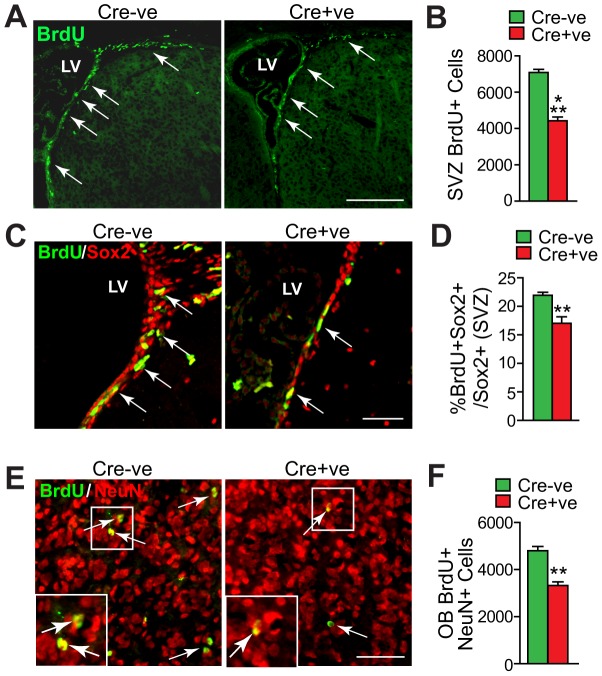
Genetic ablation of Snail perturbs the proliferation of adult forebrain neural precursor cells and the number of adult-born olfactory neurons.(A-D) Adult Snailfl/fl mice that were positive (Cre+ve) or negative (Cre-ve) for the nestin-cre transgene were injected with BrdU and coronal sections through the SVZ were analyzed one day later. (A) Fluorescence micrographs of sections through the SVZ that were immunostained for BrdU (green). Arrows denote BrdU-positive cells in the SVZ and rostral migratory stream. LV indicates the lateral ventricle. Scale bar 100 µm. (B) Quantification of sections as in A for the total relative number of BrdU-positive cells in the SVZ, as determined by counting all positive cells in 10 sections spanning the lateral ventricle (see experimental methods for details). (***p<0.01, n = 4 each). (C) Representative micrographs of coronal sections through the SVZ immunostained for BrdU (green) and Sox2 (red). Arrows denote double-labelled cells and LV indicates the lateral ventricle. Scale bar 50 µm. (D) Quantification of sections as in C for the proportion of Sox2-positive SVZ cells that were also positive for BrdU. (**p<0.01; n = 4 each). (E,F) One month old Snailfl/fl mice that were positive (Cre+ve) or negative (Cre-ve) for the nestin-cre transgene were injected multiple times with BrdU over the course of one day and the olfactory bulb was analyzed one month later. (E) Representative fluorescence micrographs of coronal sections through the olfactory bulb immunostained for BrdU (green) and NeuN (red). The boxed areas are shown at higher magnification in the insets, and arrows denote double-labelled cells. (F) Quantification of sections as in E for the total relative number of BrdU-positive, NeuN-positive cells in the olfactory bulb, as determined by counting all double-positive cells in 10 sections spanning the entirety of the olfactory bulb (see experimental methods for details). (**p<0.01; n = 3 each).